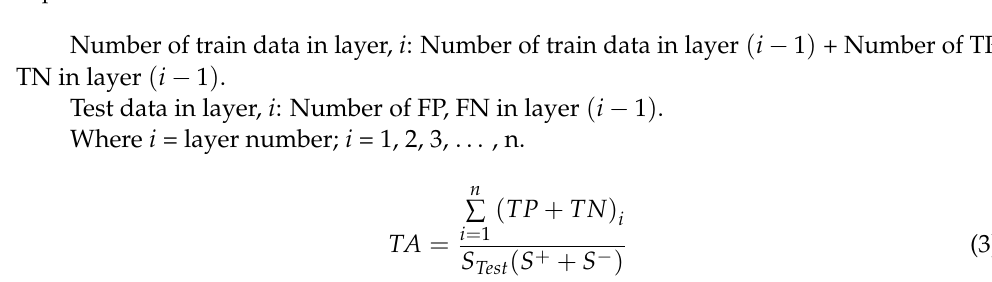
Figure 1. ( b ) (Unit B (Classification Block)) Grid search-based multilayer dynamic system (GS-MLDS) to predict 4mC sites.